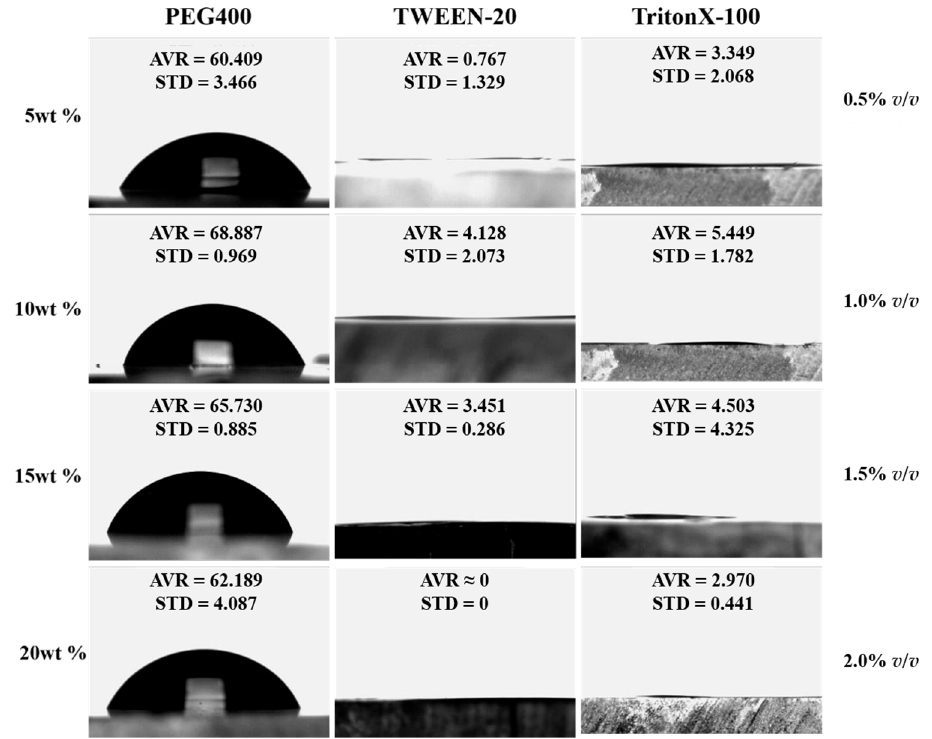
Figure 6. Contact angle of hydrophilic reagent dropping on PMMA chip.